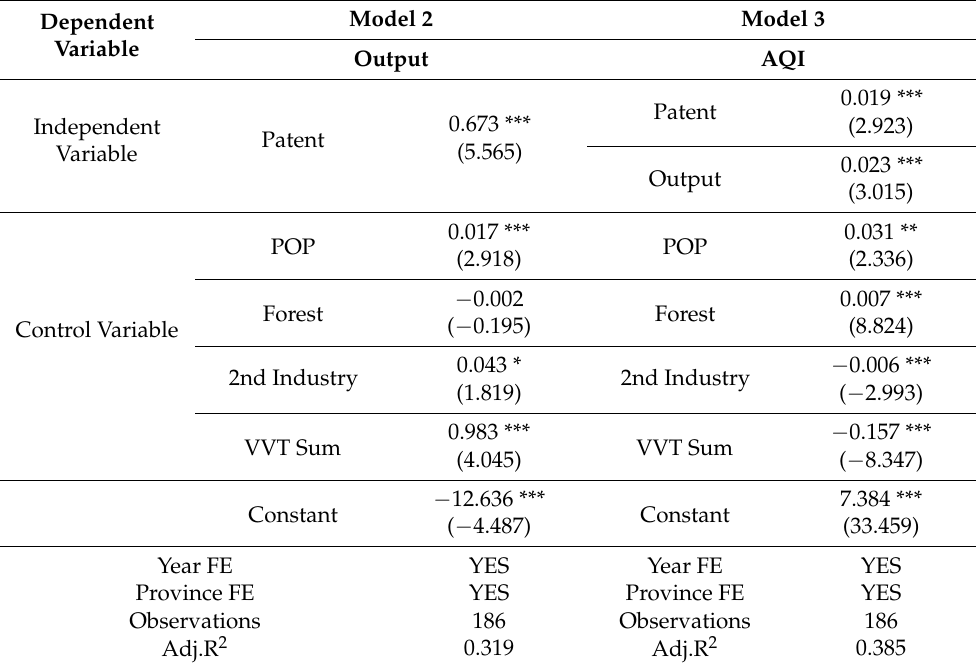
Table 6. Panel fixed effect regression results of Model 2 and Model